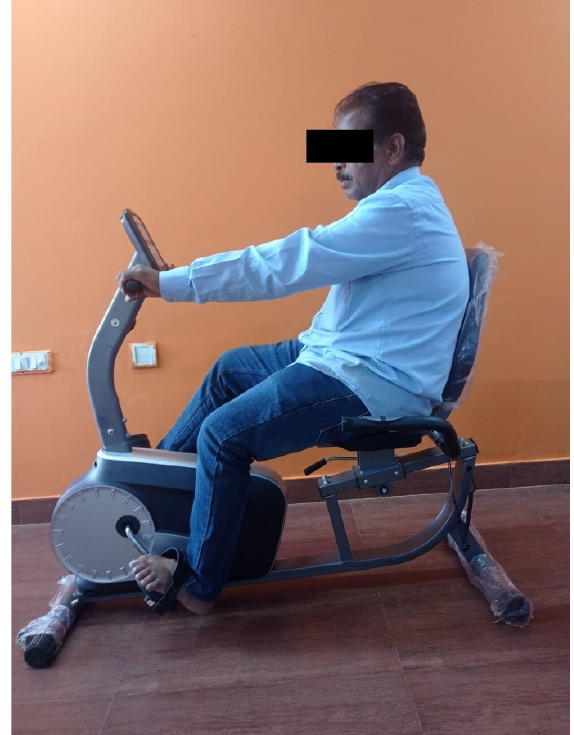
Figure 2. Patient performing static bicycle exercises .